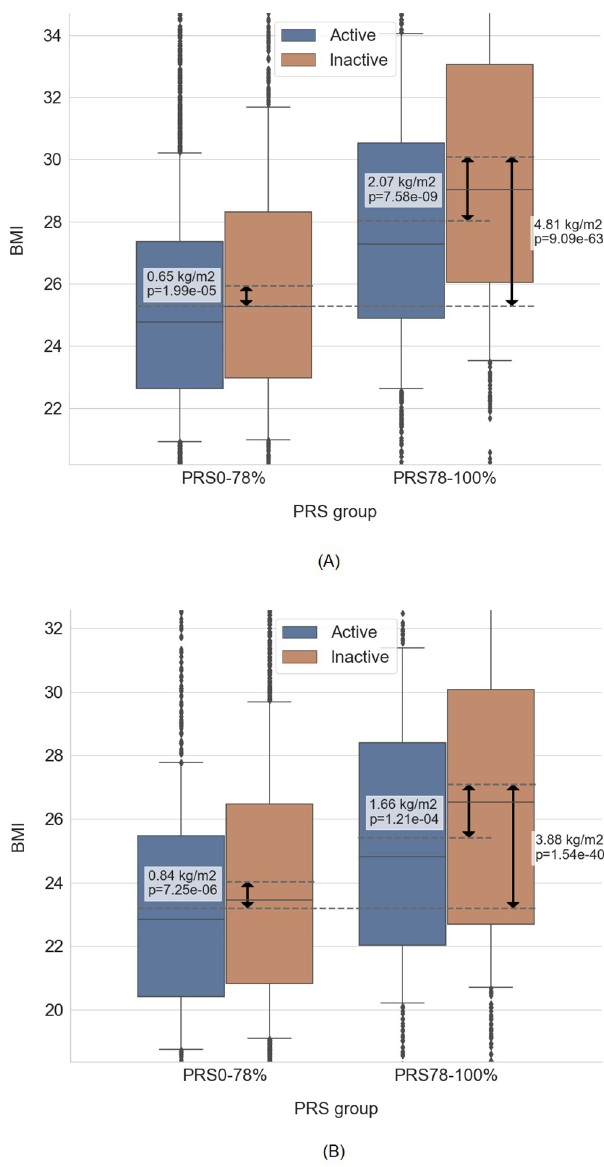
Fig 4. BMI distribution of individuals, stratified by PRS groups and levels of physical activity. (A): Discovery Inter99 dataset. (B): Validation in Genotek dataset. Graphs are cut at 10% / 90% quantiles on the y-axis (note the different scales on the panels). Solid lines represent median, boxplot outlines represent 25% / 75% quantiles, whiskers represent 10% / 90% quantiles. Dashed lines represent the mean of the respective box, which were compared in the statistical test. The difference in mean values and p-value of respective tests are shown on the plot. Both graphs show BMI, unadjusted for age and sex. Adjusted BMI residuals and outliers are available at Online Supplementary.